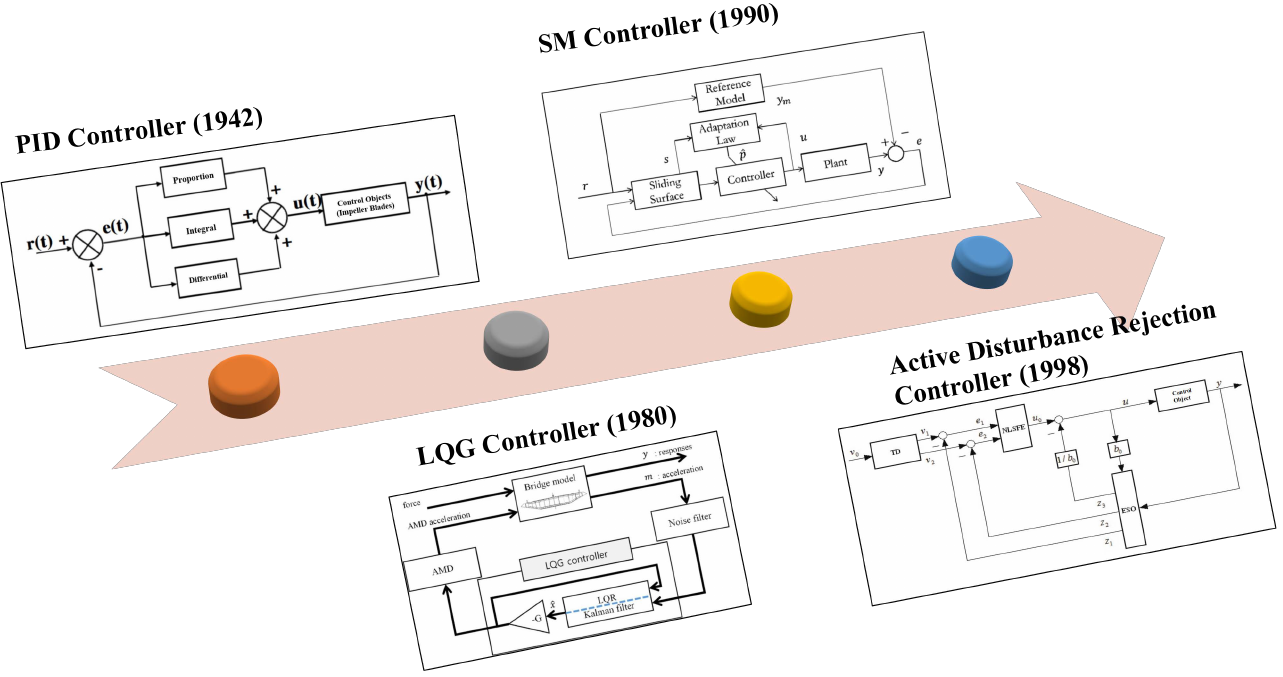
Figure 1. Timeline of the development of mainstream active flutter suppression controllers.